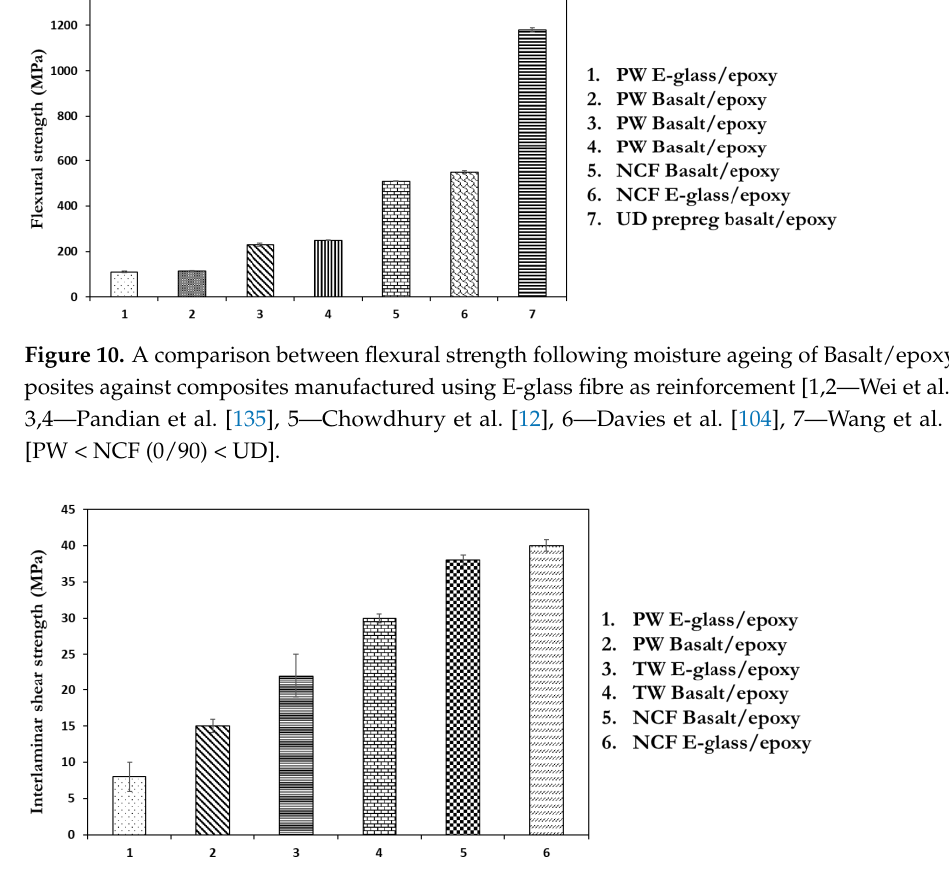
Figure 11. A comparison between interlaminar shear strength following moisture ageing of Basalt/epoxy composites against composites manufactured using E-glass fibre as reinforcement [1,2 –